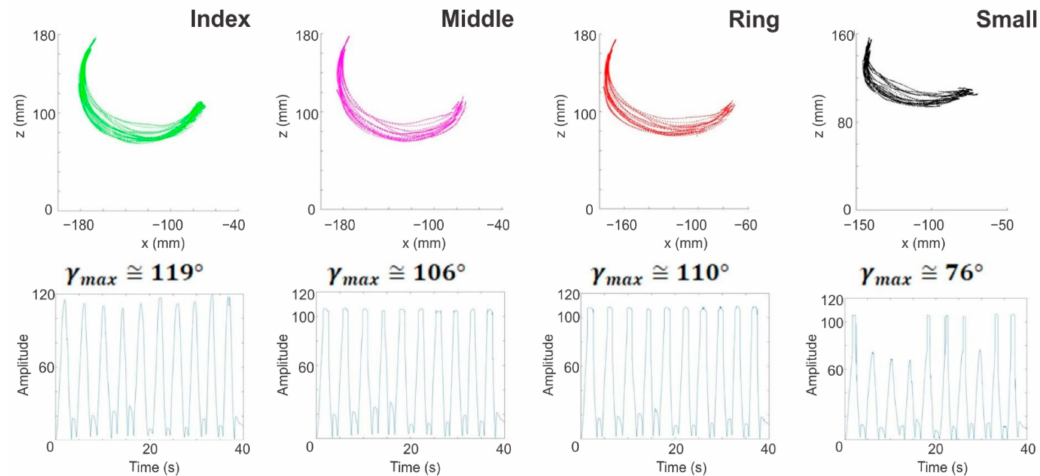
Figure 14. Real trajectories of